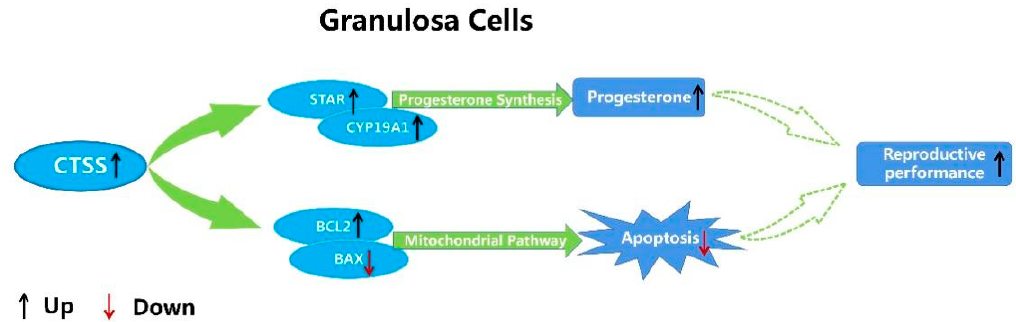
Figure 6. Molecular mechanism of CTSS regulating cell apoptosis and progesterone secretion in rabbit